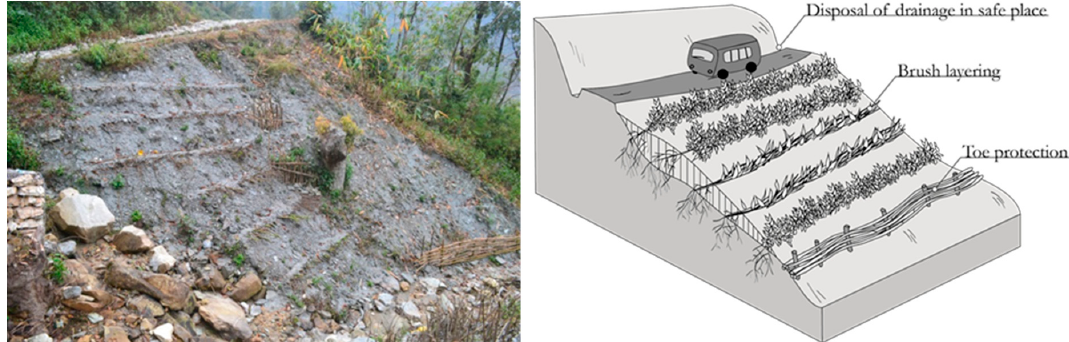
Figure 9. ( Left ) Example of soil bioengineering along roadside in Tilahar demonstration site in Parbat District, Nepal; ( Right ) schematic illustration of brush layering [57] .